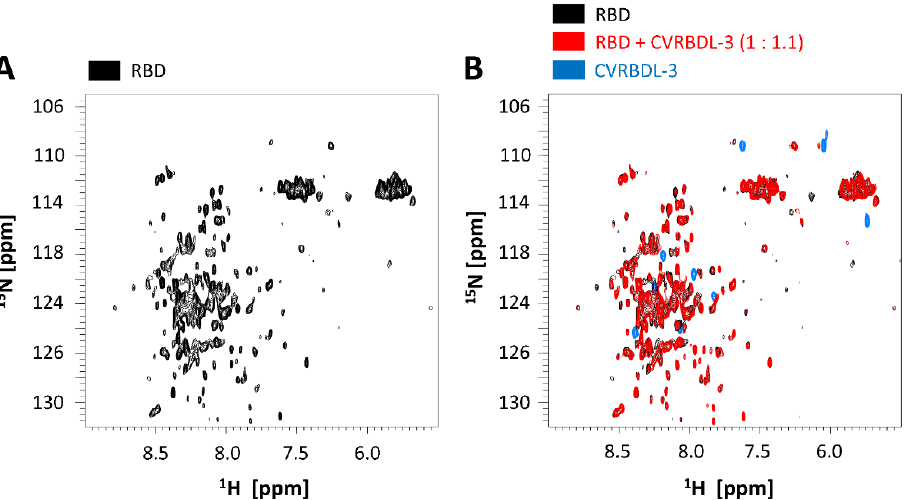
Figure 4. Two-dimensional 1 H- 15 N HMQC spectra (at 1.2 GHz proton frequency) of the RBD domain (natural abundance) in absence ( A ) and presence ( B ) of the peptide CVRBDL-3. ( A ) Reference spectrum of the RBD alone. ( B ) The spectrum of the RBD domain alone (black) is overlaid with the spectra of the RBD in presence of the peptide (red), as well as the isolated peptide (blue). Next, the CVRBDL ‐ 3 peptide was added to the RBD domain at a molar ratio of about 1.1:1 (peptide: RBD domain). The resulting spectrum showed decreased intensities for